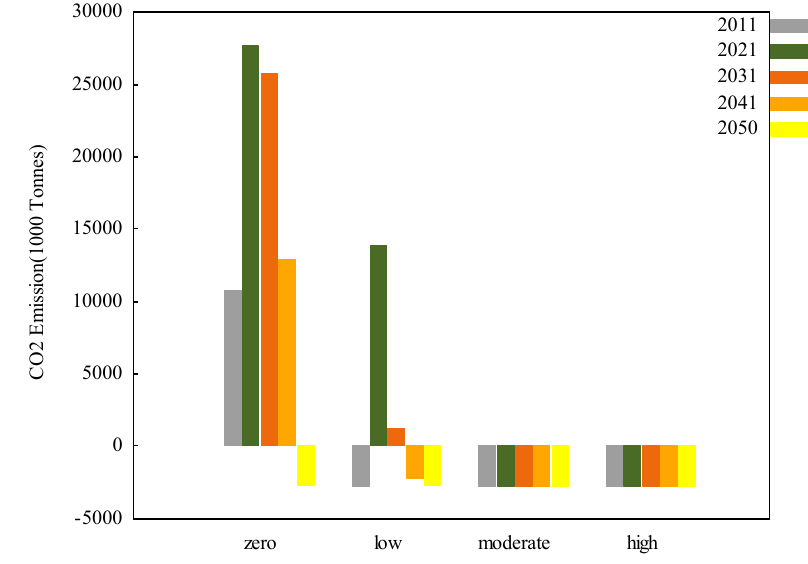
Figure 8. GHG emissions due to land-use change (LUC) under subsidy action.